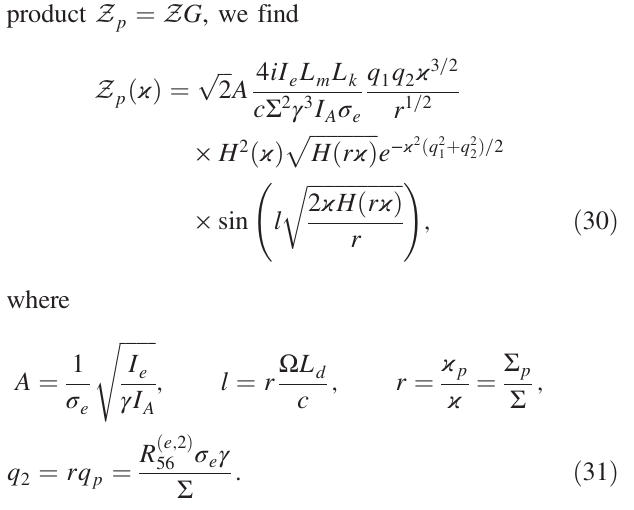
FIG. 4. Plot of the function dots show the result of the simulation of the amplification factor (see Sec.